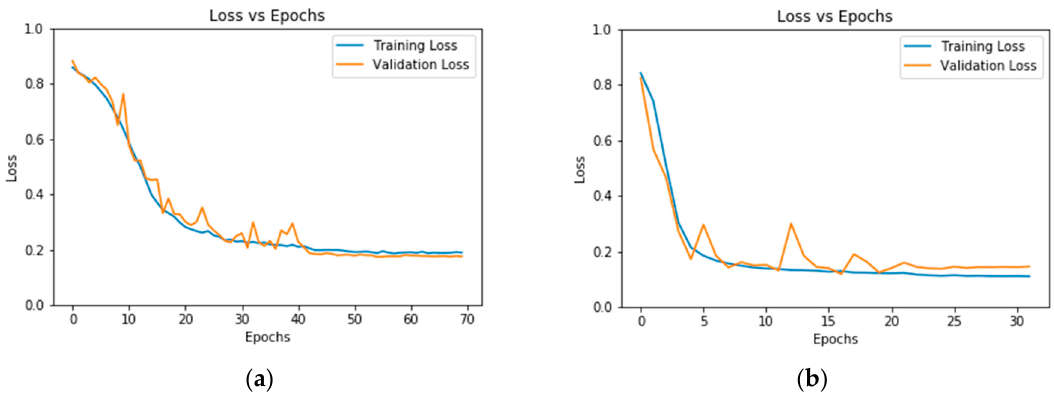
Figure 19. Intensity normalization maps associated with an HDL 32E LiDAR unit for ( a ) ROI 1, ( b ) ROI 2, and ( c ) ROI 3.